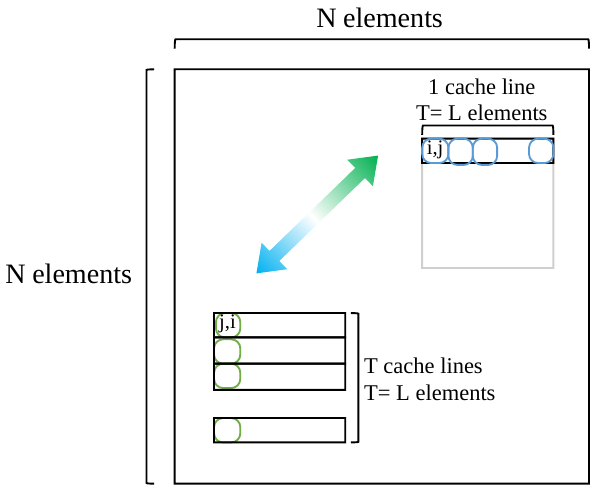
Figure 3. In-place transposition of a row-major stored N